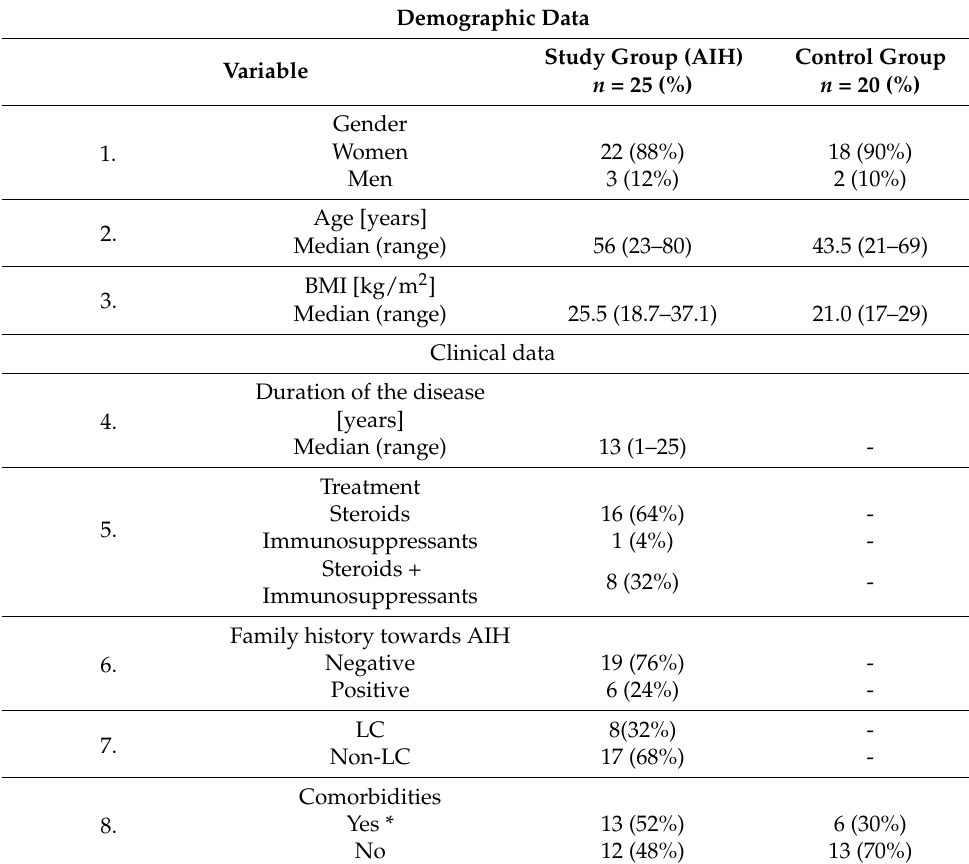
Table 1. Characteristics of the study group and control